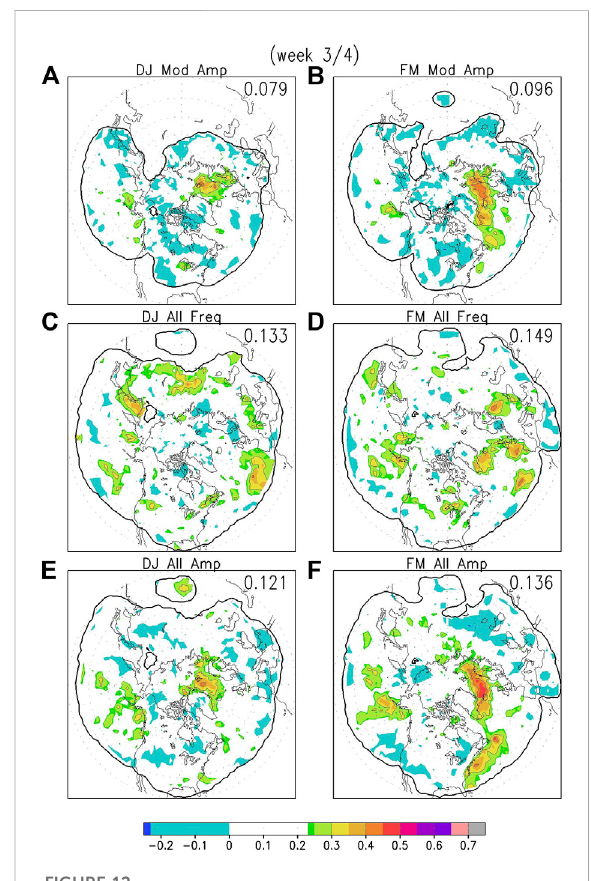
FIGURE 12 (A) ACC scores for weeks 3-4 hindcasts of cyclone amplitude of moderate cyclones for early winter (December/January); (B) Sameas (A) butforlatewinter(February/March); (C,D) :Sameas (A, B) but for weeks 3-4 hindcasts of cyclone track frequency of al cyclones; (E,F) : Same as (A,B) but for weeks 3-4 hindcasts of cyclone amplitude of all